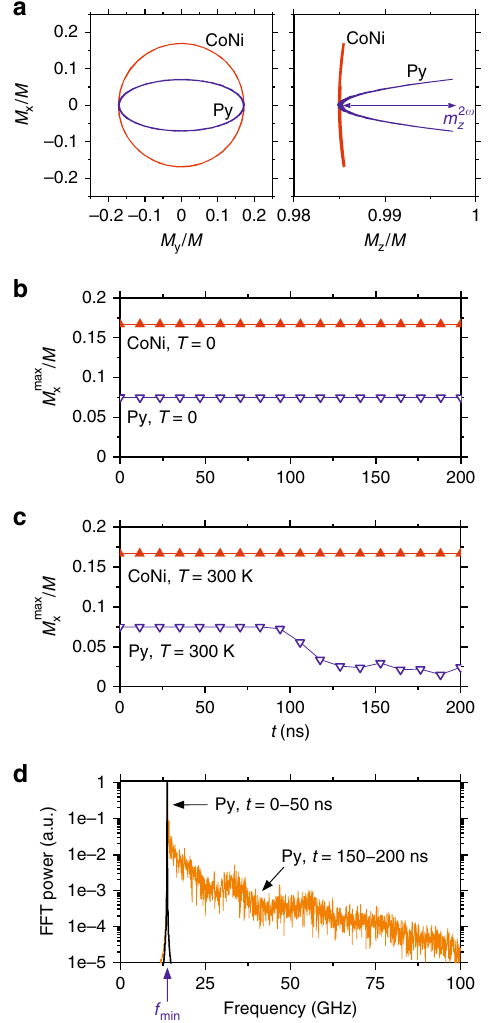
Fig. 5 Analysis of nonlinear damping based on the micromagnetic simulations. a Calculated magnetization trajectories for the lowest- frequency spin-wave states in Py and CoNi, as labeled. m z 2 ω labels the double-frequency dynamic component of magnetization, which serves as a parametric pumping source for the nonlinear spin-wave excitation. b , c Temporal evolution of the free precession amplitude starting with a large initial amplitude at t = 0, at T = 0 ( b ) and T = 300 K ( c ). The simulations were performed with negligible linear damping, emulating the damping compensation by the spin current. d Fourier spectra of magnetization oscillations in Py before ( t = 0-50 ns) and after ( t = 150 – 200 ns) the onset of nonlinear